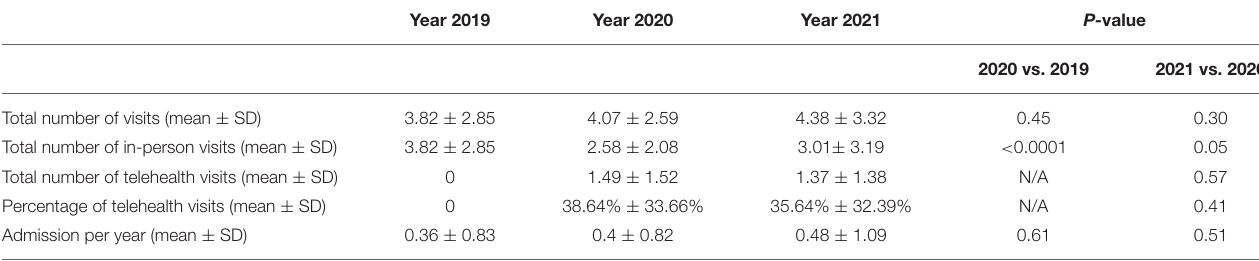
TABLE 4 | Admission rate and volume of in-person and telehealth